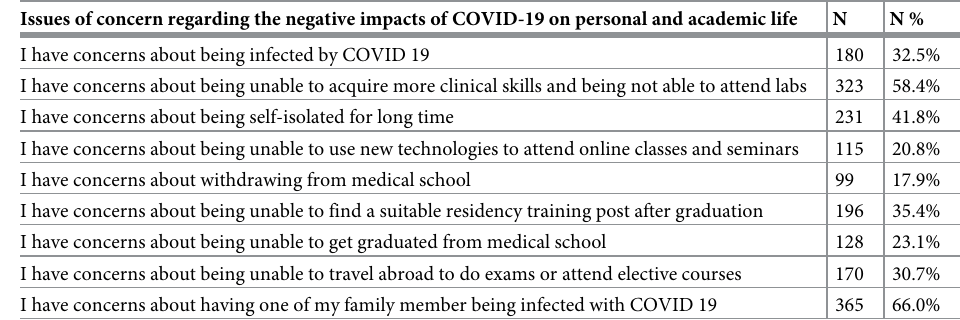
Table 2. Concerns of participants about negative impact of COVID-19.